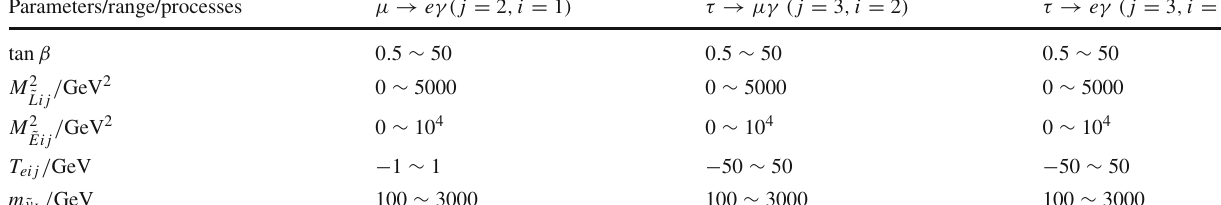
Table 1 Scanning parameters for Figs. 8, 10 and 11. Without special statement, the non-zero values of non-diagonal elements m 2 ˜ corresponding to l j → l i γ are shown in the column